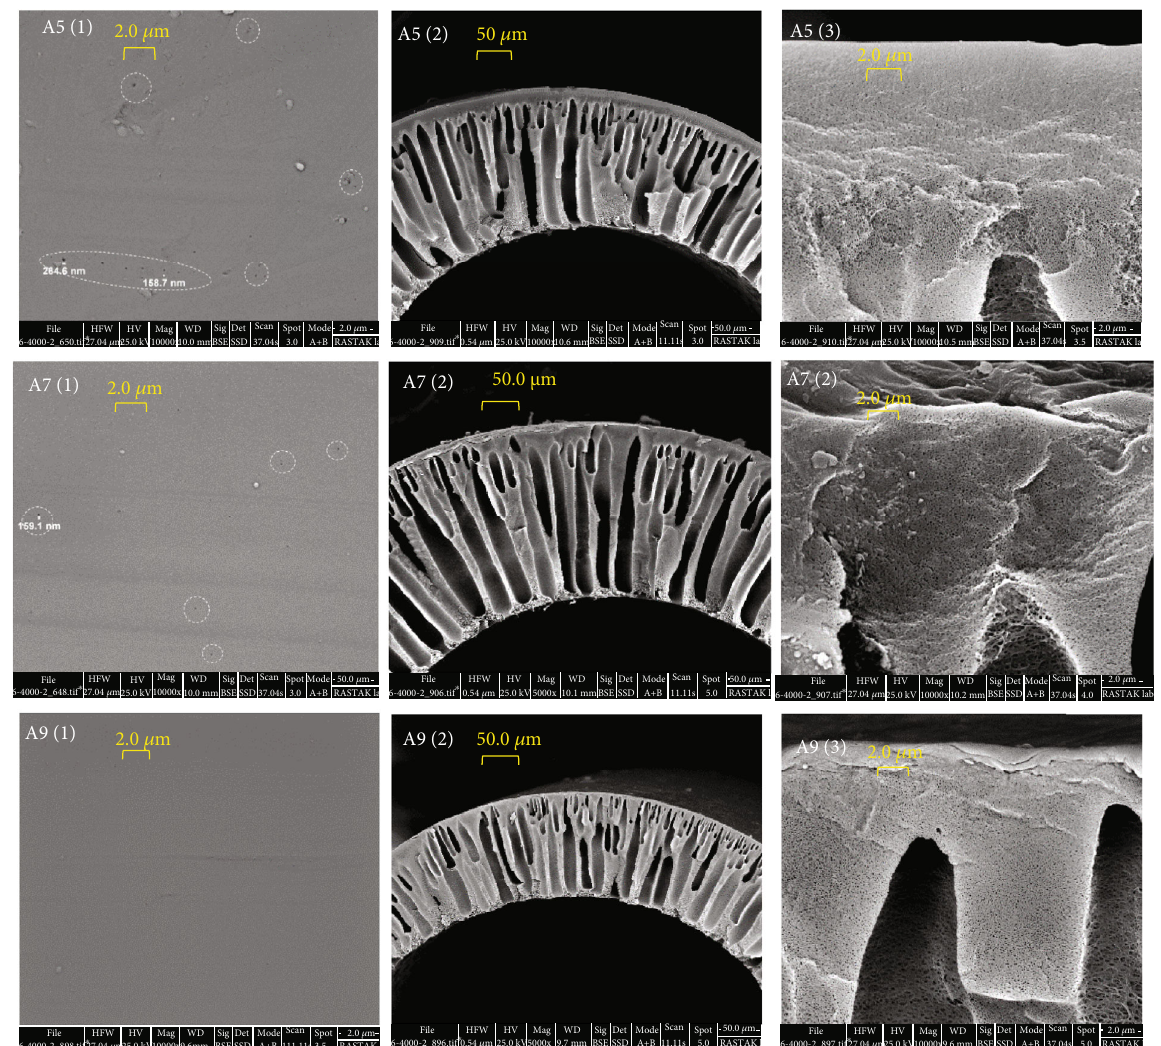
Figure 8: E ff ect of air gap distance on morphologies of PAN hollow fi bers: (a) outer surface; (b) cross-section; (c) skin layer cross-section (A5: 5cm, A7: 7cm, A9: 9